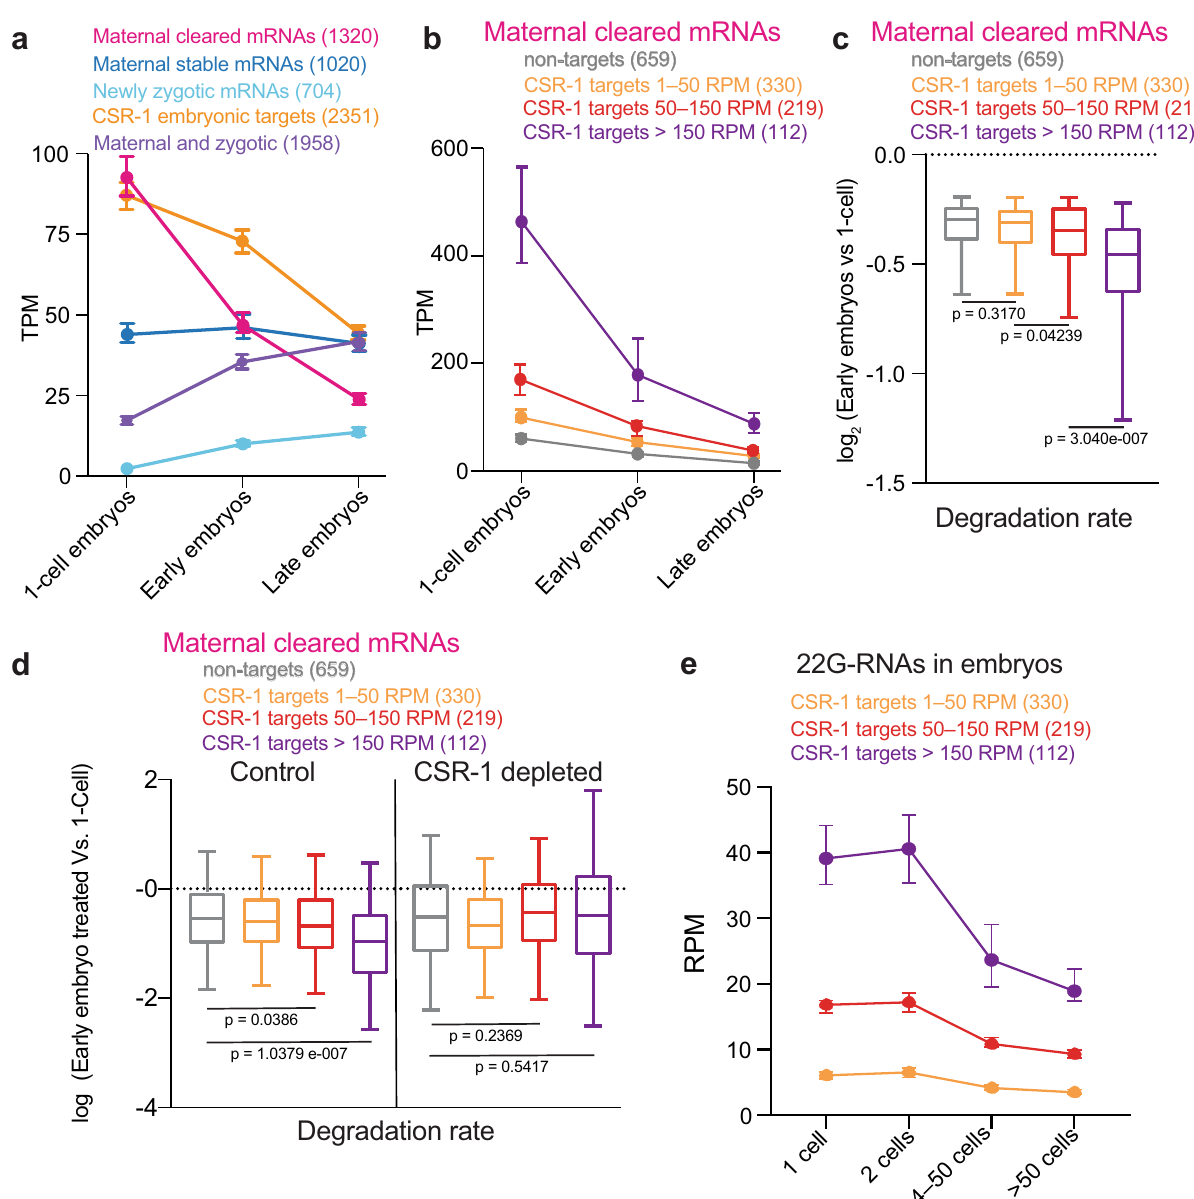
Fig. 3 CSR-1 contributes to quicken the degradation rate of maternal cleared mRNA targets. a Detection of maternal cleared mRNAs, maternal stable mRNAs, newly zygotic mRNAs, maternal and zygotic mRNAs, and CSR-1 embryonic target mRNAs by RNA-seq from sorted 1-cell stage, early stage, and late stage embryos. Data are presented as median and 95% con fi dent interval of normalized read abundances in transcript per million (TPM). The sample size n (genes) is indicated in parentheses. b Detection of maternal cleared mRNAs for gene sets of increasing 22G RNA density, 1 – 50 RPM, 50 – 150 RPM, >150 RPM or non-target genes using RNA-seq normalized reads from sorted 1-cell stage, early stage, and late stage embryos. Data are presented as median and 95% con fi dent interval of normalized read abundances in transcript per million (TPM). The sample size n (genes) is indicated in parentheses. c Box plots showing the degradation rate of maternal cleared mRNAs for gene sets of increasing 22G RNA density, 1 – 50 RPM, 50 – 150 RPM, >150 RPM or non-target genes. The degradation rate was calculated by the ratio of normalized RNA-seq reads of cleared maternal mRNAs in sorted early embryos versus 1-cell embryos. d Box plots showing the degradation rate as in c , using normalized RNA-seq reads of cleared maternal mRNAs in control or CSR-1- depleted early embryos versus sorted 1-cell embryos. e 22G-RNA levels from sorted embryos enriched in 1-, 2-, 4 – 50-, and 50-cell stage. Data are presented as median and 95% con fi dent interval of normalized read abundances in reads per million (RPM) from gene sets of increasing 22G RNA density, 1 – 50 RPM, 50 – 150 RPM, >150 RPM. In c , d , the line indicates the median value, the box indicates the fi rst and third quartiles, and the whiskers indicate the 5th and 95th percentiles, excluding outliers. Two-tailed P values were calculated using Mann – Whitney – Wilcoxon tests. The sample size n (genes) is indicated in parentheses. Source data are available maternal mRNA targets, we measured the degradation rate of of 22G-RNAs compared to non-target mRNAs (Fig. 3d). Finally, maternal cleared mRNAs in CSR-1-depleted embryos. Our we analyzed the dynamics of 22G-RNAs on sorted embryo analysis shows that the depletion of CSR-1 impaired the higher populations at different stages (Supplementary Fig. 4f). Our level of degradation of CSR-1 mRNA targets with a high density analysis shows that the 1-cell embryos are already provided with a